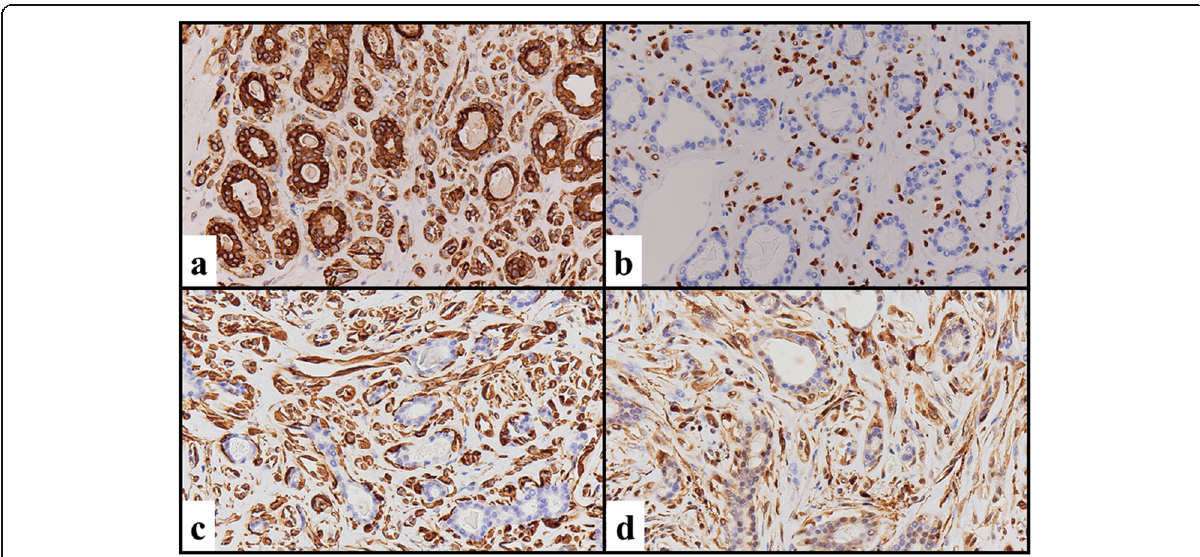
Fig. 3 Immunohistochemical findings. a The cuboidal cells in the inner layer were positive for pan-cytokeratin (cytoplasm), and the outer layer of cells and polygonal and spindle cells were weakly positive for pan-cytokeratin (cytoplasm). b - d The cuboidal cells in the inner layer were negative for p63 ( b ), HHF35 ( c ) and S-100 ( d ), whereas the outer layer of cells and polygonal and spindle cells were positive for p63 (nucleus) ( b ), HHF35 (cytoplasm) ( c ) and S-100 (nucleus and cytoplasm) ( d )